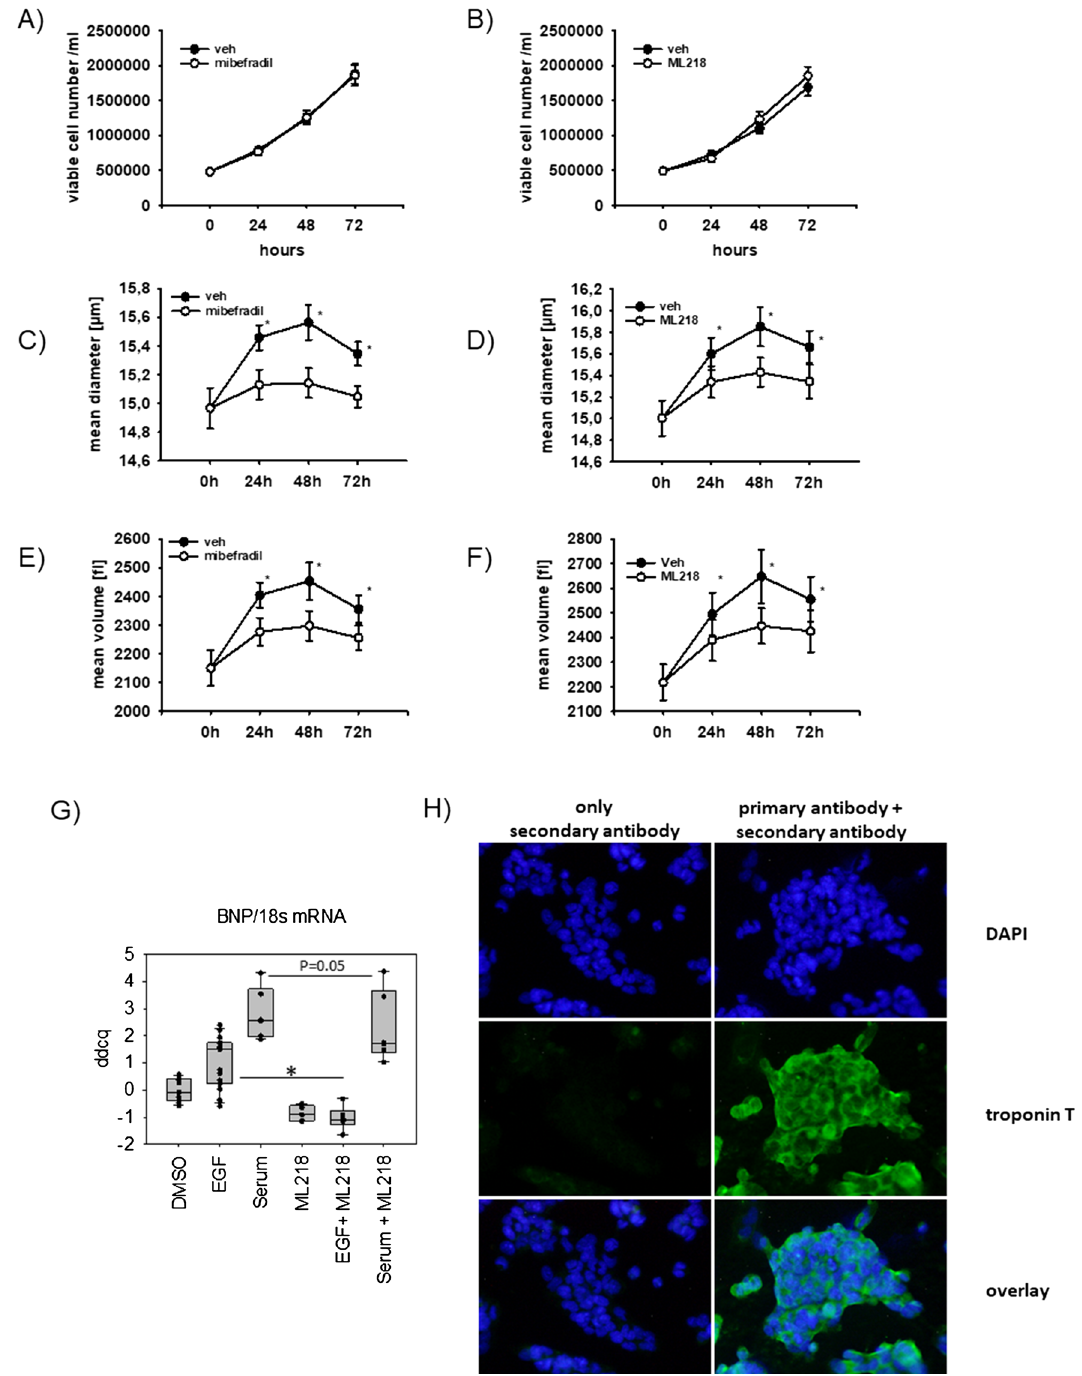
Figure 6. Effect of T-type calcium channel inhibitors on cell proliferation and mean cellular diameter and cell volume of HL-1 cells. ( A + B ) Assessment of cell proliferation of HL-1 cells over 72 h in the presence and absence of T-type calcium channel inhibitors. 300,000 HL-1 cells were seeded in 3 cm petri dishes and cultivated in Claycomb medium with serum for 24 h prior to measurements. Proliferation of cells was measured after 0, 24, 48 or 72 h by counting viable cells with a Casy Cell Counter and Analyzer. Cells were either incubated with vehicle (veh), 1 µM ML218 ( A ) or 1 µM mibefradil ( B ), two T-type calcium channel inhibitor (N = 6; n = 11–12 for mibefradil and control, N = 9; n = 17–18 for ML218 and control). All quantitative data represented as mean ± SEM; * p ≤ 0.05. ( C - F ) Determination of mean cell diameter and volume in HL-1 cells by resistance measurements with a Casy Cell Counter and Analyzer. Mean cell diameter ( C + D ) and mean volume ( E + F ) were quantified in HL-1 cells as indicated. (N = 6; n = 11–12 for mibefradil and control, N = 9; n = 17–18 for ML218 and control). All quantitative data represented as mean ± SEM; * p ≤ 0.05. ( G ) As marker for cardiomyocyte hypertrophy, BNP mRNA levels were quantified in HL-1 cells incubated with either vehicle (DMSO), 10 µg/l EGF, 10% serum, 1 µM ML218 or combinations thereof, n = 6–16, * p ≤ 0.05. ( H ) Representative immunofluorescence images of HL-1 cells stained with DAPI and troponin T primary antibody and secondary antibody or only secondary